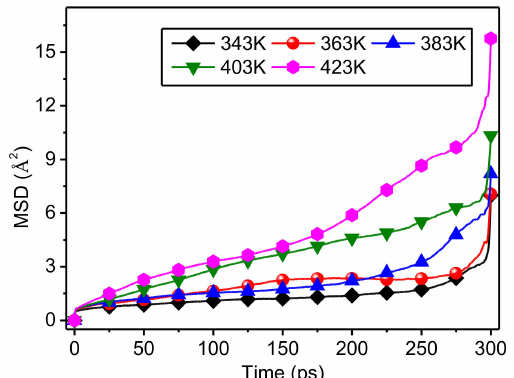
Figure 7. MSD time curves for amorphous regions of meta-aramid fibers at different